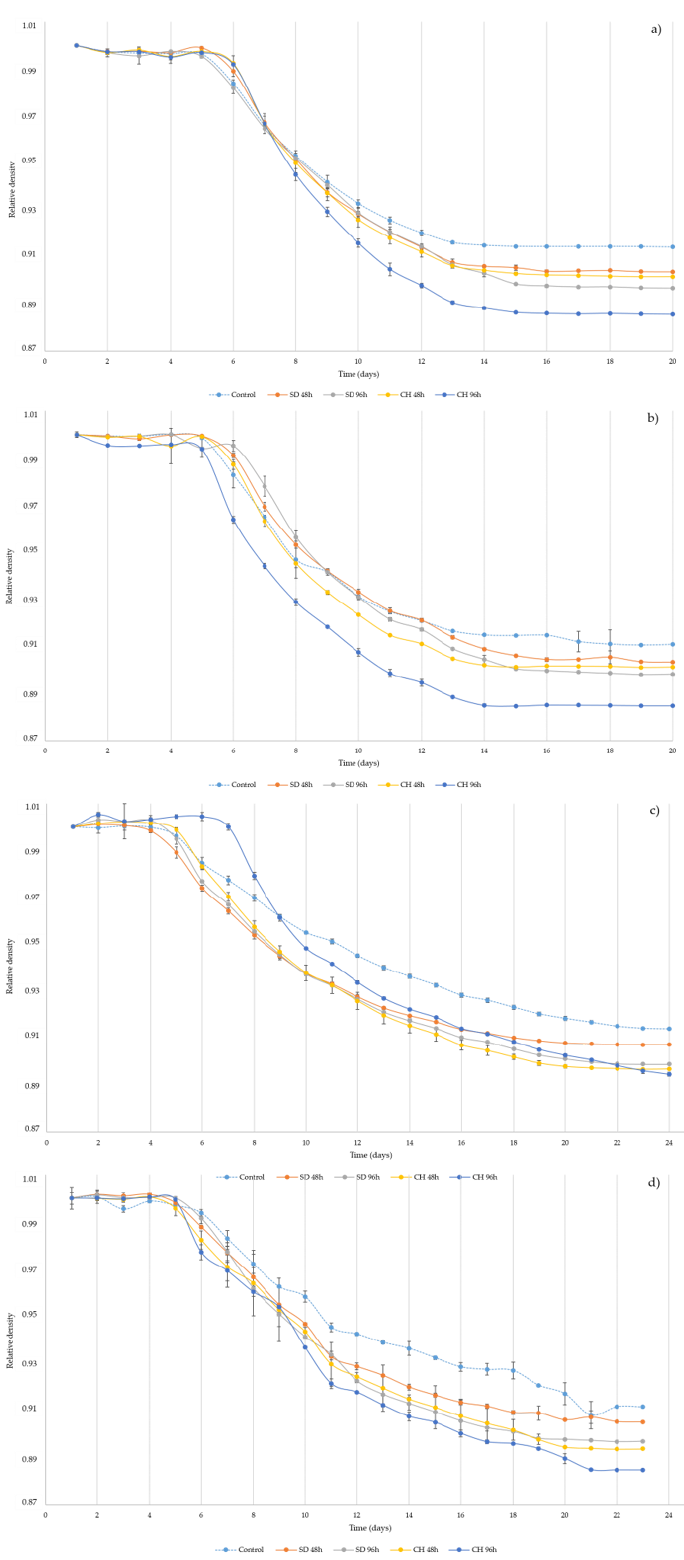
Figure 2. ( a – d ) Relative density evolution during grape must alcoholic fermentation without ( a , c ) and with ( b,d ) the presence of grape skins during two vintages (2018, a , b, and 2019, c , d ). Control: without over-ripening. SD48h: sun-dried grapes during 48 h. SD96h: sun-dried grapes during 96 h. CH48h: climatic chamber drying during 48 h. CH96h: climatic chamber drying during 96